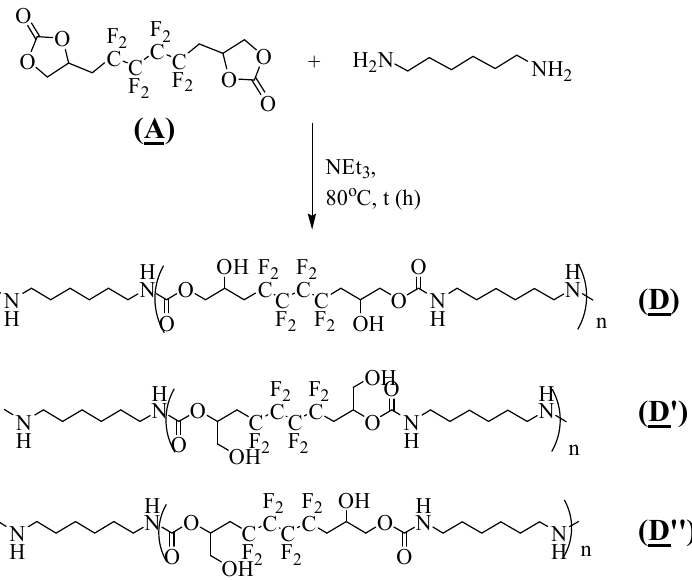
Figure 8. Synthesis of FPHUs by polyaddition of ( A ) with hexamethylenediamine.